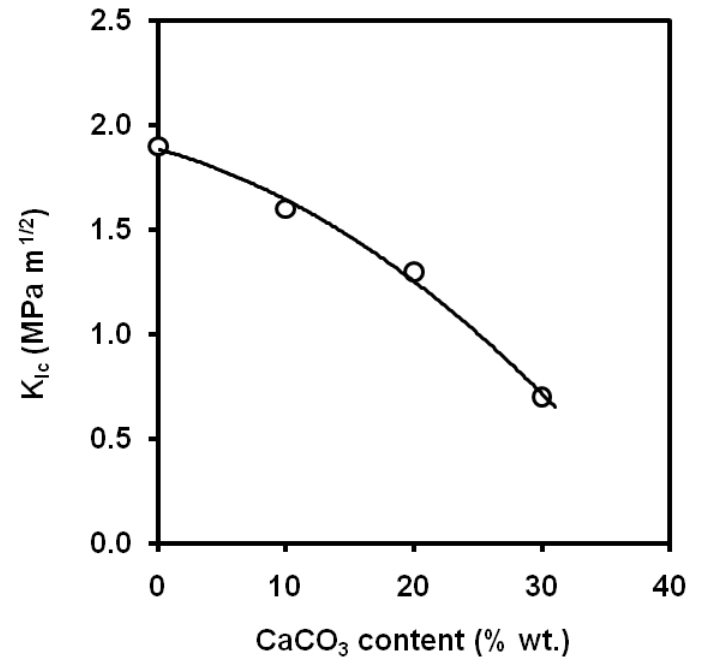
content on the values of K 3